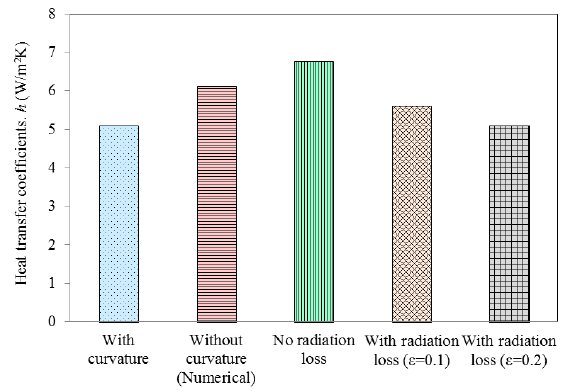
Figure 13. Heat transfer coefficient from the numerical and analytical results for